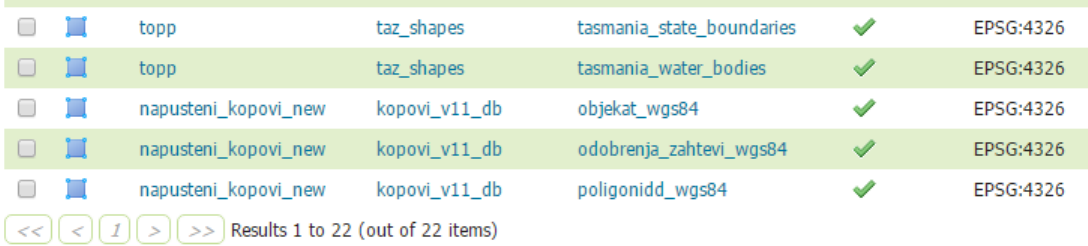
Figure 9. The web GIS services published on GeoServer.